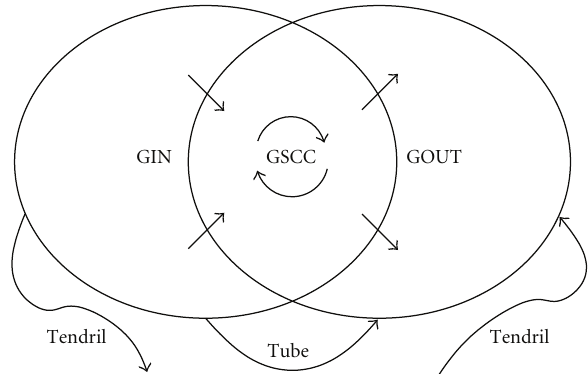
Figure 1: Schematic diagram of the giant components of an EPN. Note that the GIN and GOUT both include the GSCC. Tendrils are directed paths out of the GIN or into the GOUT that do not enter or leave the GSCC; a tube is a tendril that goes from the GIN to the GOUT. An initial infection in the GIN will lead to the infection of the entire GOUT (including the GSCC). If the initial infection is outside the GSCC, it will also infect a few tendrils or tubes and a few nodes in the GIN outside the GSCC. Since these are small components, their existence does not a ff ect the calculation of the asymptotic probability and attack rate of a major epidemic. Adapted from